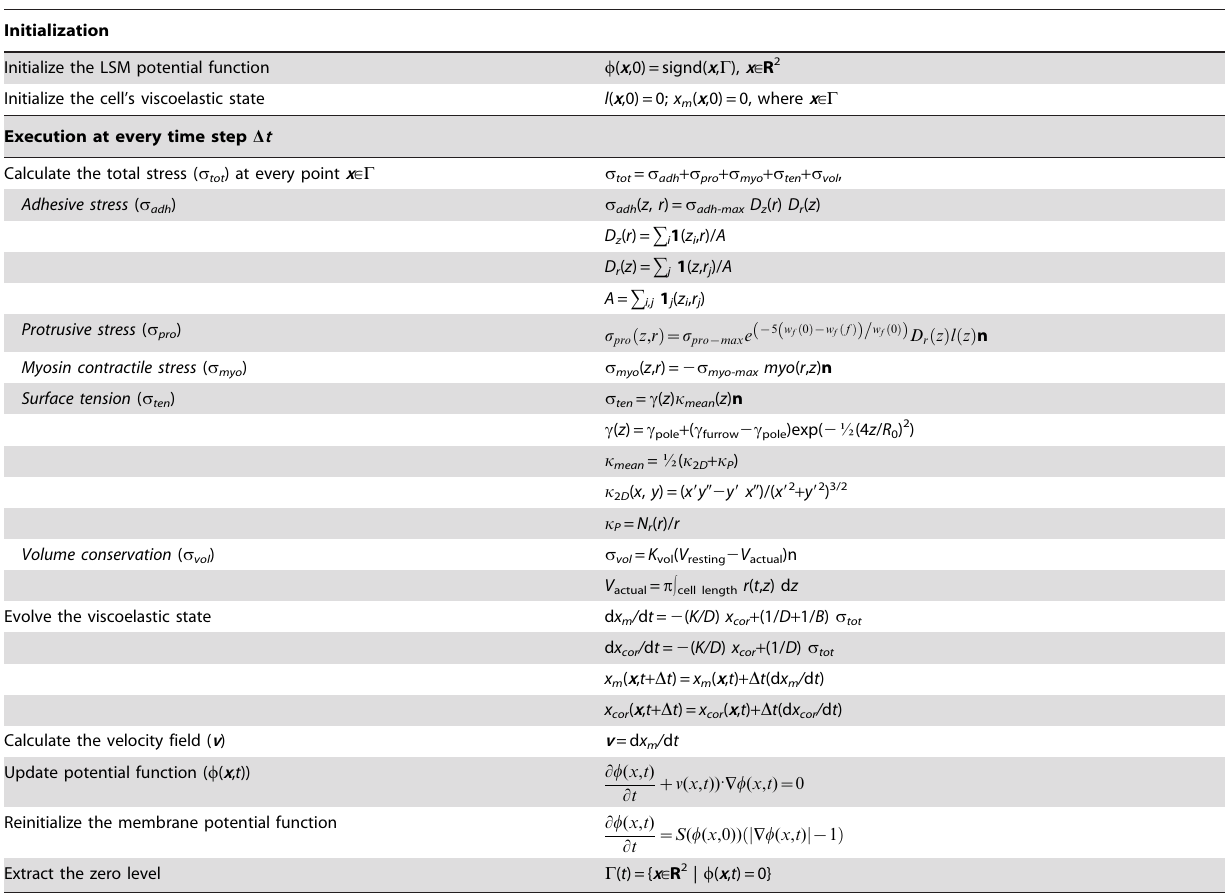
Table 3. Algorithm